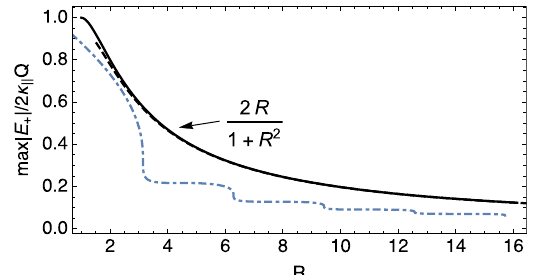
FIG. 3. The normalized maximum accelerating field as a function of the transformer ratio. The solid black line is given by Eq. (30). The dot dashed and dashed lines correspond to the cases (a) and (b) described in the text. As seen in this plot, the case (b) is practically indistinguishable from the theoretical